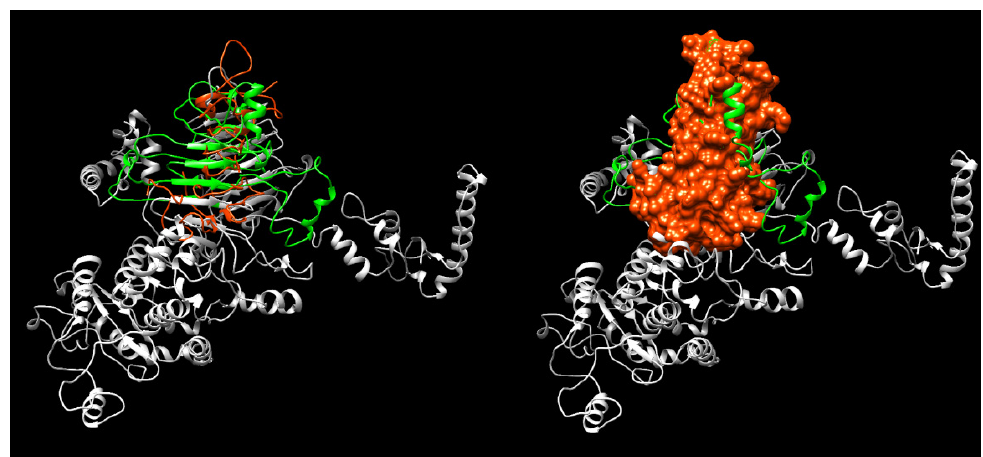
Figure 2. Prediction of α -hemolysin quaternary structure. rHlyA structure aligned to the complete HlyA protein. (Left) Ribbon structures ( green: actual region on the inferred whole HlyA; red: inferred rHlyA structure); (Right) rHlyA molecule surface.